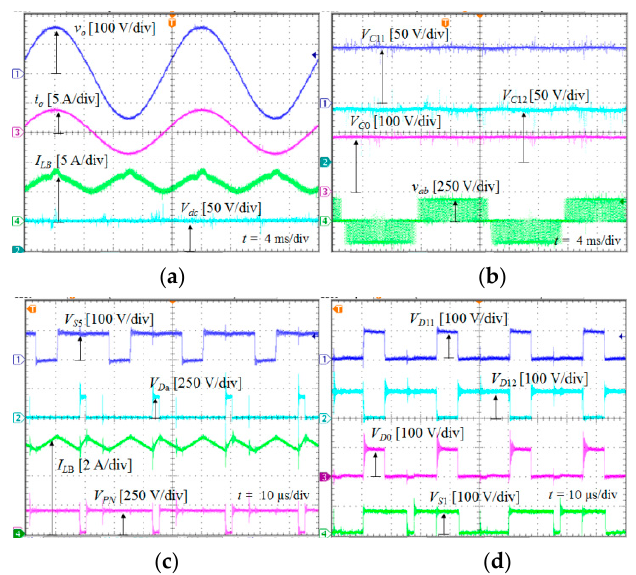
Figure 9. Experimental waveforms for the proposed inverter when V dc = 50 V. From top to bottom: ( a ) output voltage after the L-C filter, load current, input current, and input voltage; ( b ) voltages across capacitors C 11 , C 12 , and C 0 , and output voltage before the L-C filter, ( c ) drain-source S 5 voltage, diode D a voltage, input current, and dc-link voltage; and ( d ) voltages across diodes D 11 , D 12 , and D 0 , and the drain-source S 1 voltage.